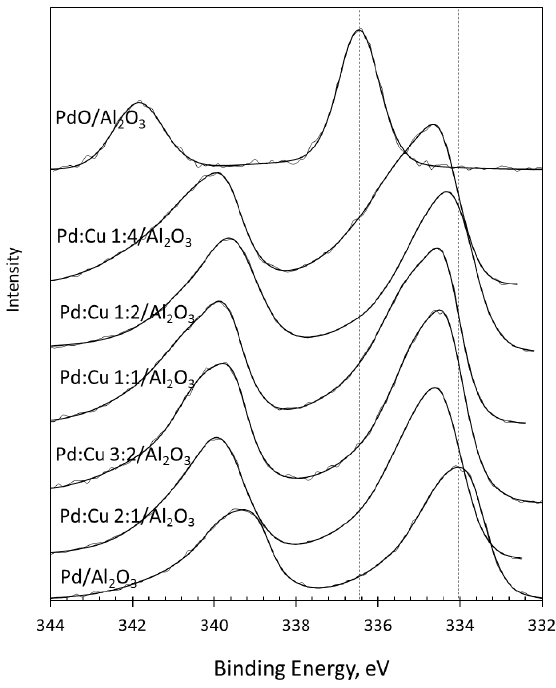
Figure 4. X-ray photoelectron spectra of the Pd 3d of each catalyst. Figure 4. X ‐ ray photoelectron spectra of the Pd 3d of each catalyst. Figure 4. X ‐ ray photoelectron spectra of the Pd 3d of each catalyst.